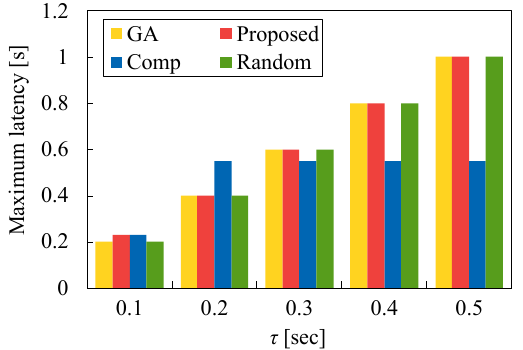
Figure 12. Maximum latency for each method versus τ in the case of N 1 = 50 and λ =